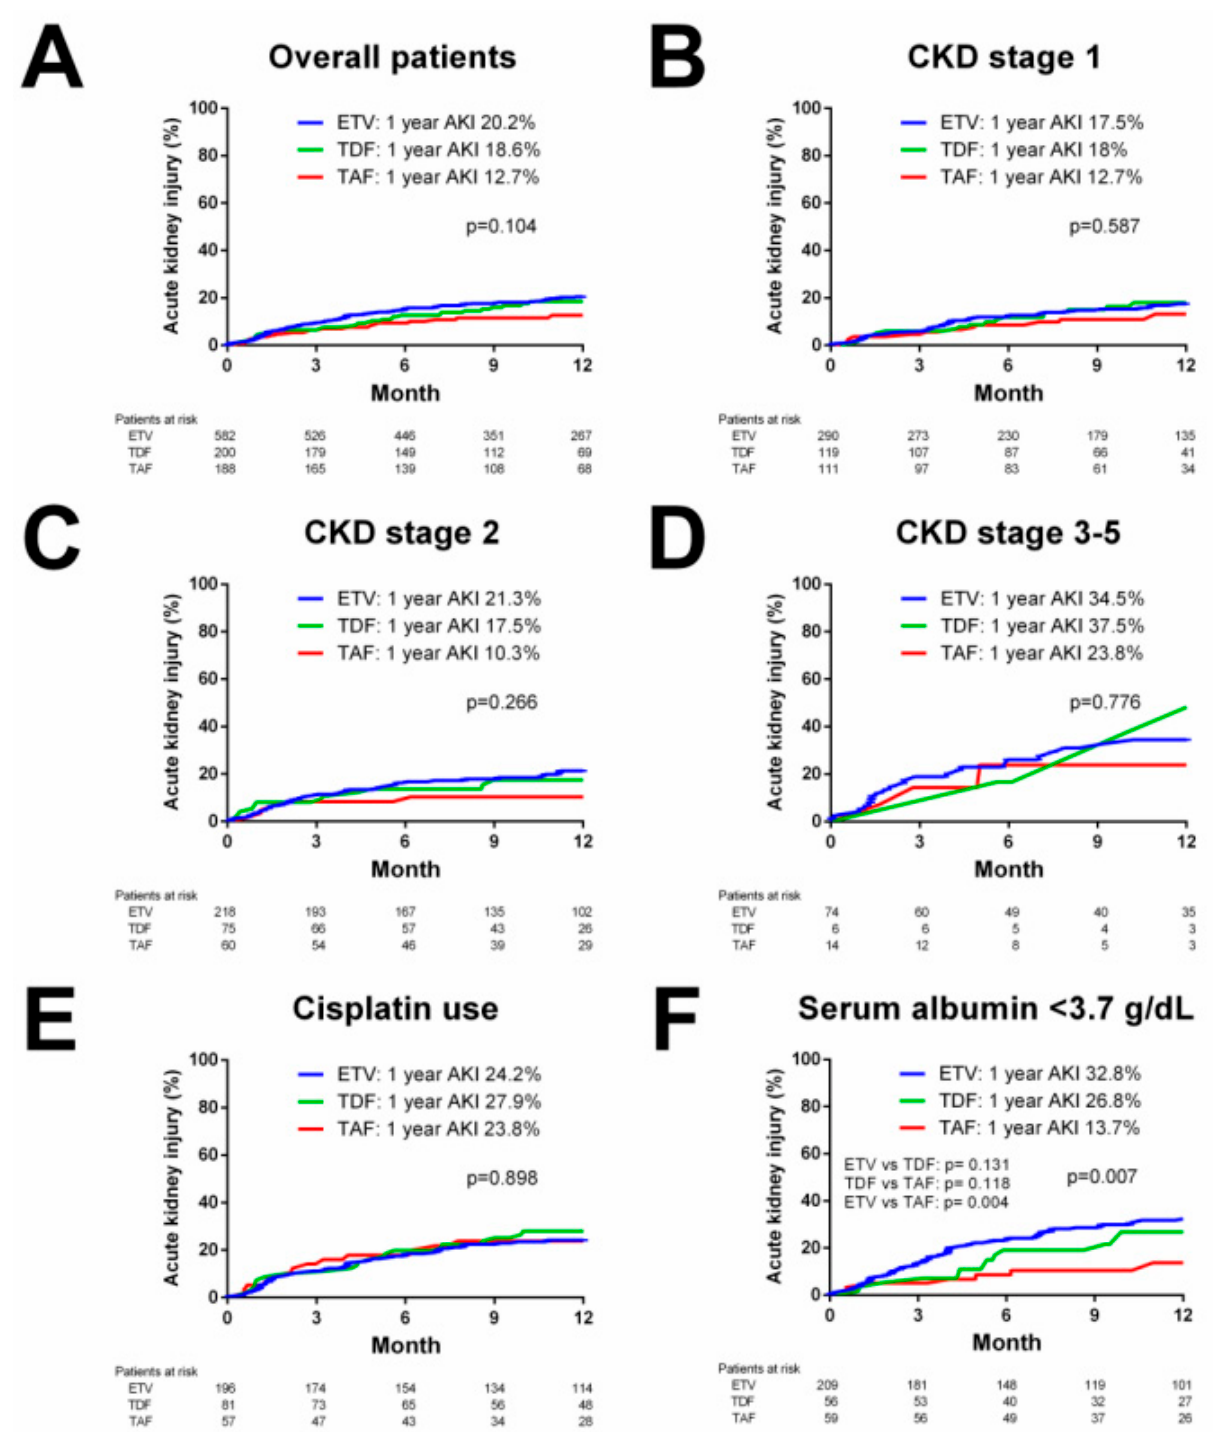
Figure 2. Cumulative incidence of acute kidney injury (AKI) during entecavir (ETV), tenofovir disoproxil fumarate (TDF) and tenofovir alafenamide (TAF) therapy. ( A ) Cumulative incidence of AKI in overall patients. ( B ) Cumulative incidence of AKI in subgroup patients with CKD stage 1. ( C ) Cumulative incidence of AKI in subgroup patients with CKD stage 2. ( D ) Cumulative incidence of AKI in subgroup patients with CKD stage 3–5. ( E ) Cumulative incidence of AKI in subgroup patients with cisplatin use. ( F ) Cumulative incidence of AKI in subgroup patients with serum albu- min <3.7 g/dL.